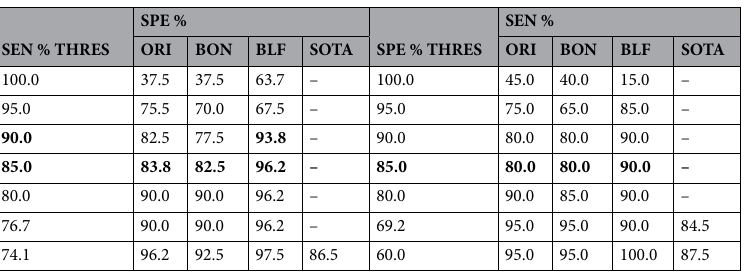
Table 6. Performance evaluated over the MClass-D dataset using different thresholds. In bold, three models achieve high efficiency, especially BLF that reaches SPE 93.8% with SEN